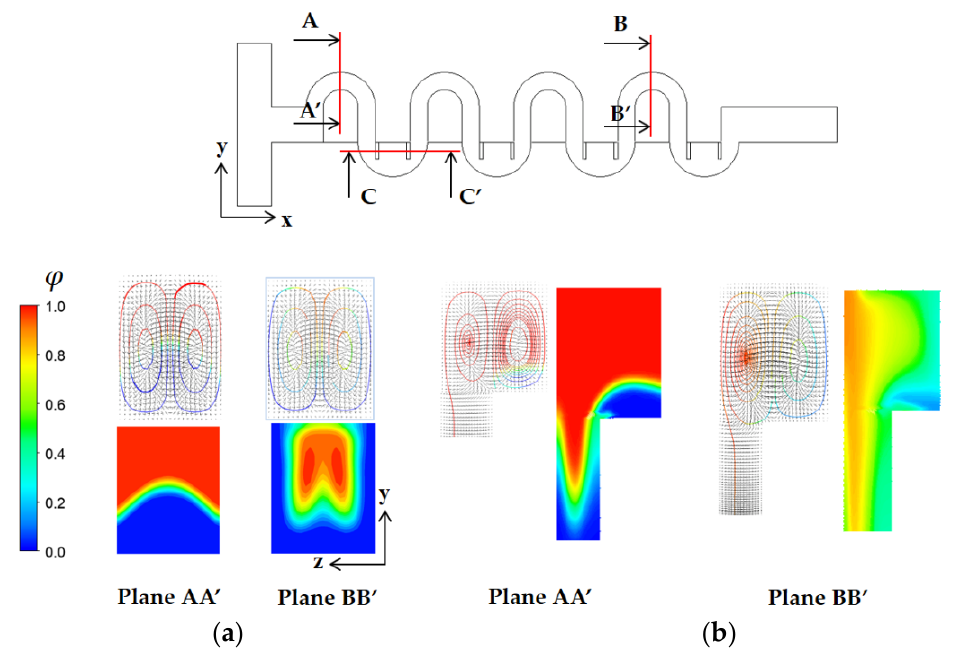
Figure 8. Comparison of projected streamlines and concentration distribution for Re = 10: ( a ) No submergence and ( b ) Submerged, W s = 60 μ m.